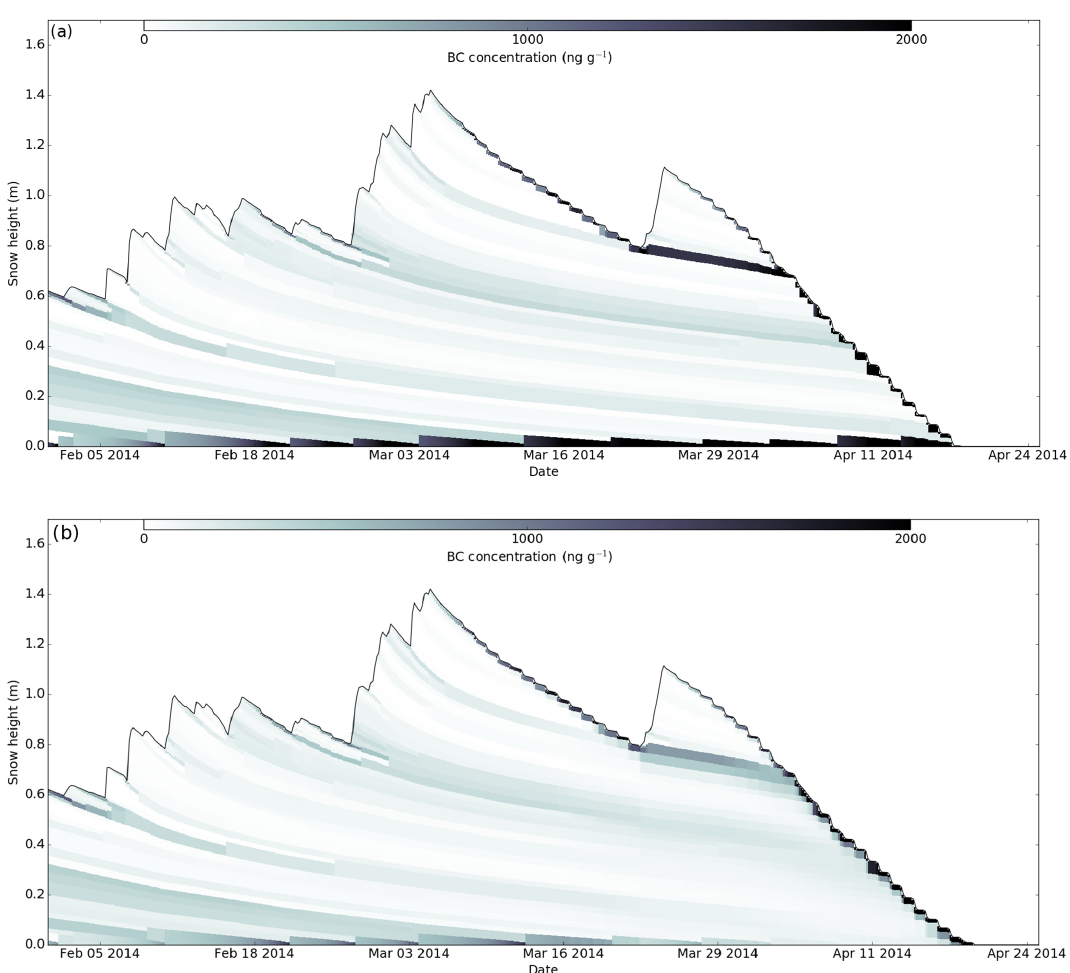
Figure 2. Simulated BC concentration evolution at the end of the 2013–2014 snow season at the Col de Porte. (a) corresponds to a simulation without scavenging, whereas (b) corresponds to a simulation using the value of 20% for BC